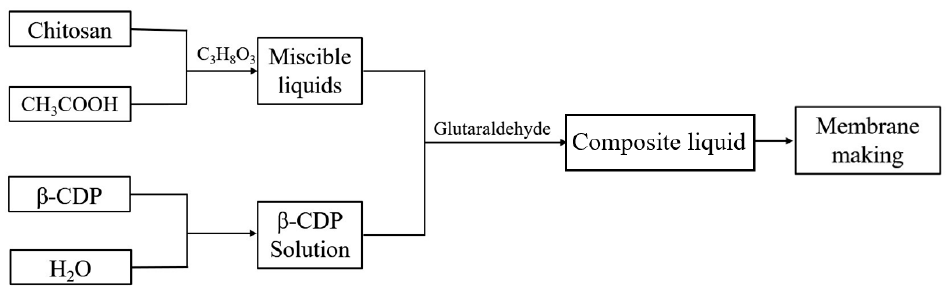
Figure 11. Flow chart of the preparation of CS/ β -CDP composite membrane.